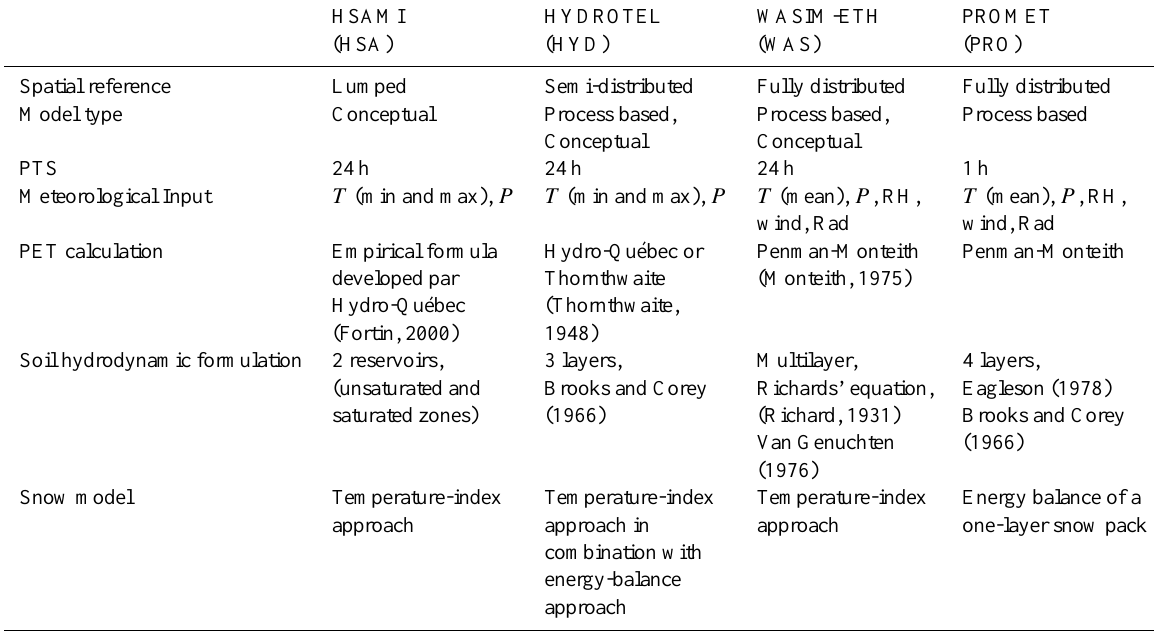
Table 1. Characteristics of the hydrological model ensemble.